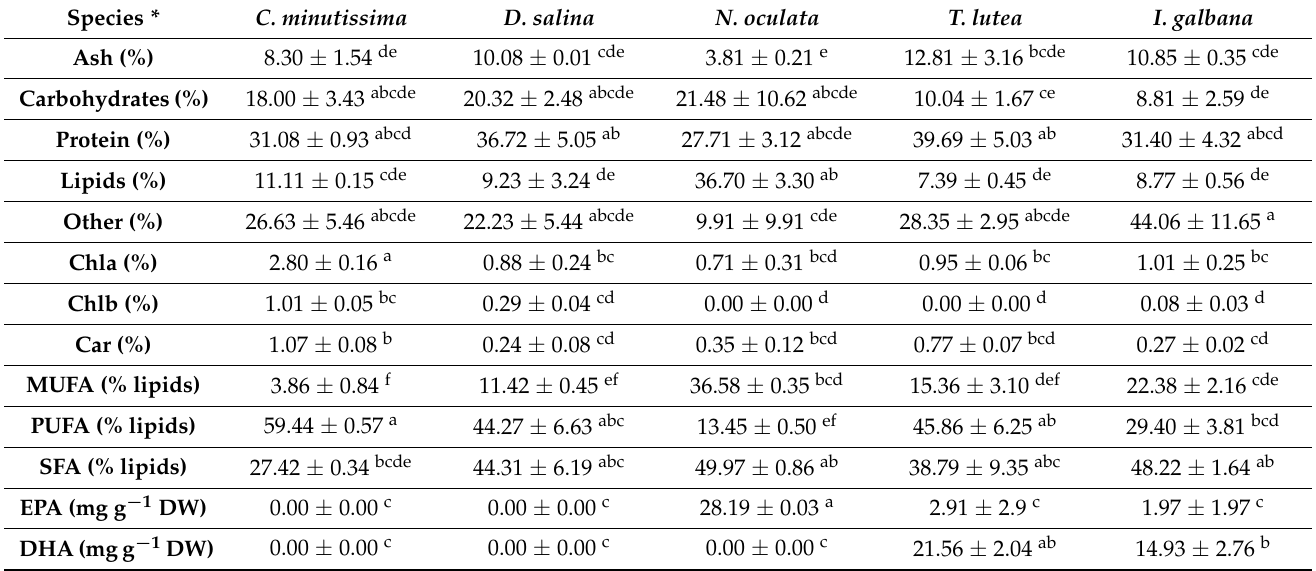
Table 2. Biomass composition, lipid analysis and EPA/DHA content of C. minutissima , D. salina , N. oculata and T. lutea during the late stationary phases. Values are given ± the standard deviation.